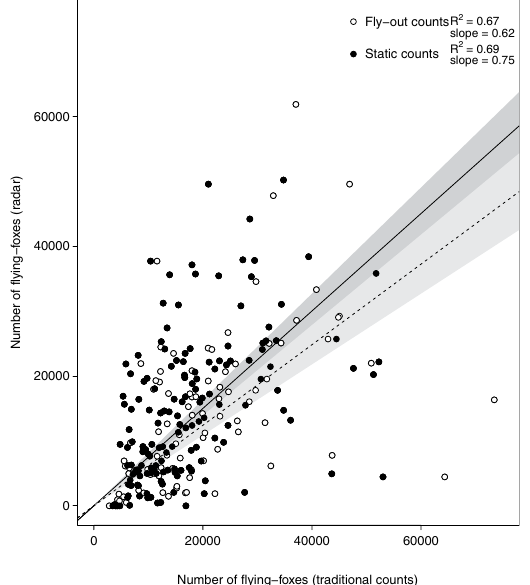
Figure 2. Radar-based estimates versus ground-based estimates of the numbers of flying-foxes present at the Yarra Bend roost. Ground-based counts are divided into fly-out (white dots, dashed line, n = 90) and static (black dots, solid line, n = 156) colony counts. The lines are fits from linear models constrained to pass through 0. Alpha shading bands indicating the 95% confidence intervals are included for each line as grey polygons (static counts = dark grey; fly-out counts = light grey). Adjusted R 2 s and slopes are included in the legend.